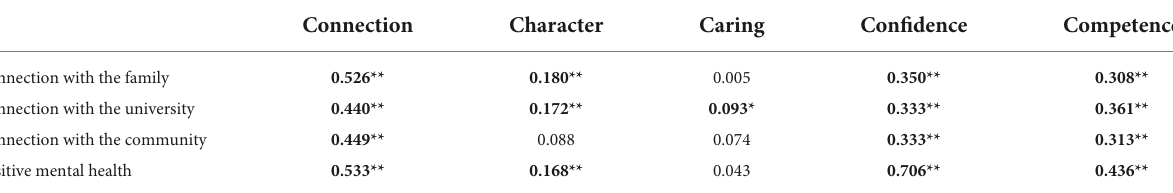
TABLE 3 Correlations between variables.